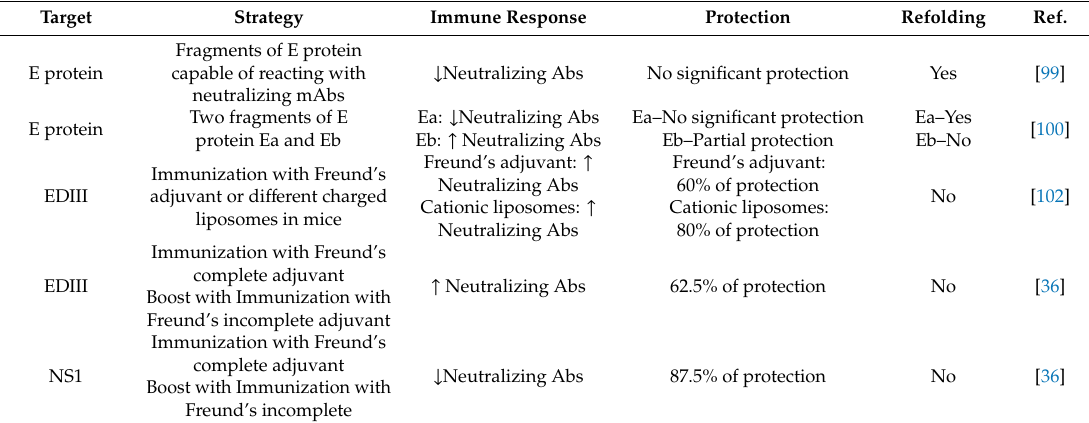
Table 2. Strategies for JEV subunit vaccines produced in E. coli for preclinical